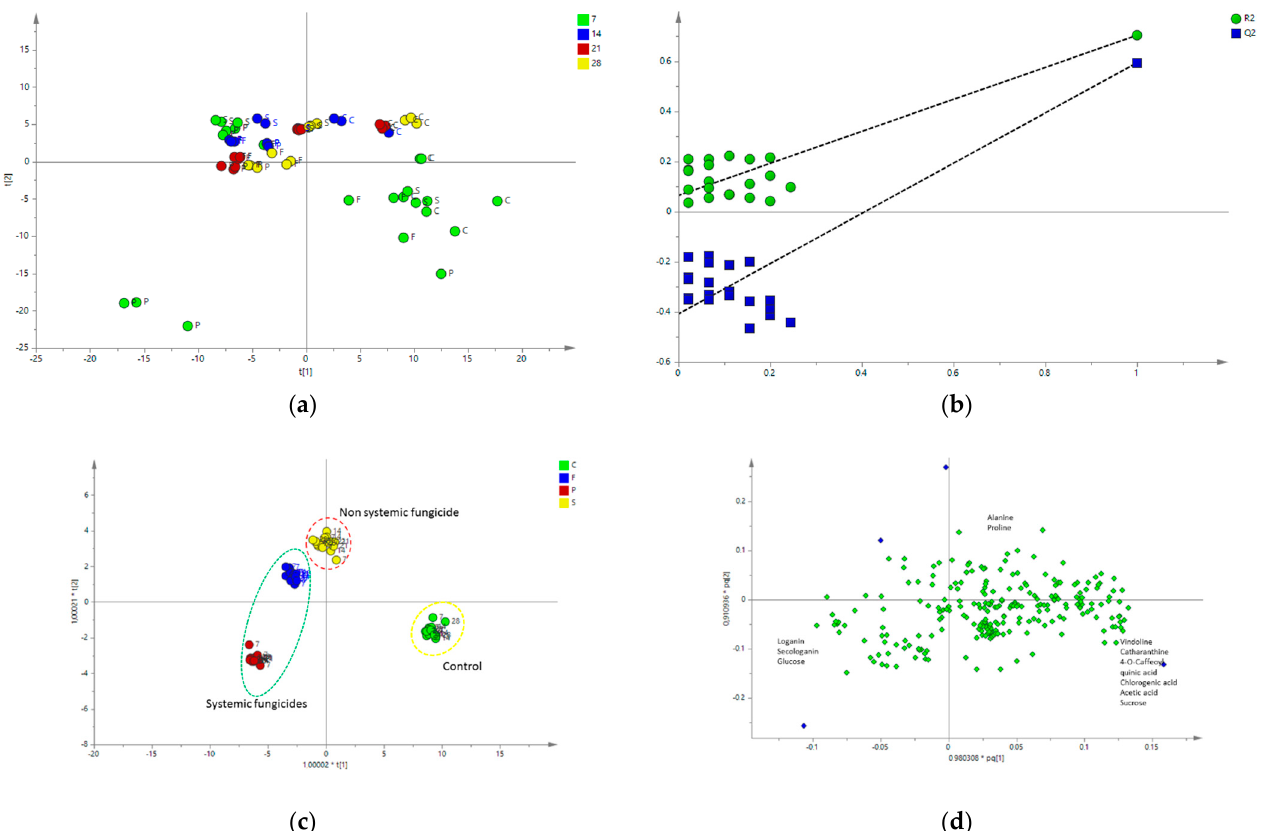
Figure 7. ( a ) Score scatter plot showing result of the PLS-DA with all of the seedling samples treated with 0.03% fungicides. ( b ) Permutation of the PLS-DA model. ( c ) Score scatter plot of OPLS-DA. ( d ) OPLS-DA loadings scatter plot of the all treated seedlings: 0.03% Pronto Plus, 0.03% Folicur, and 0.03% Switch; 0.001% Pronto Plus and 0.001% Folicur; 0.005% Switch. The numbers correspond to harvesting time (7, 14, 21, and 28 days after treatment) and the letters to fungicides (P—Pronto Plus, F—Folicur, and S—Switch) and control—C.